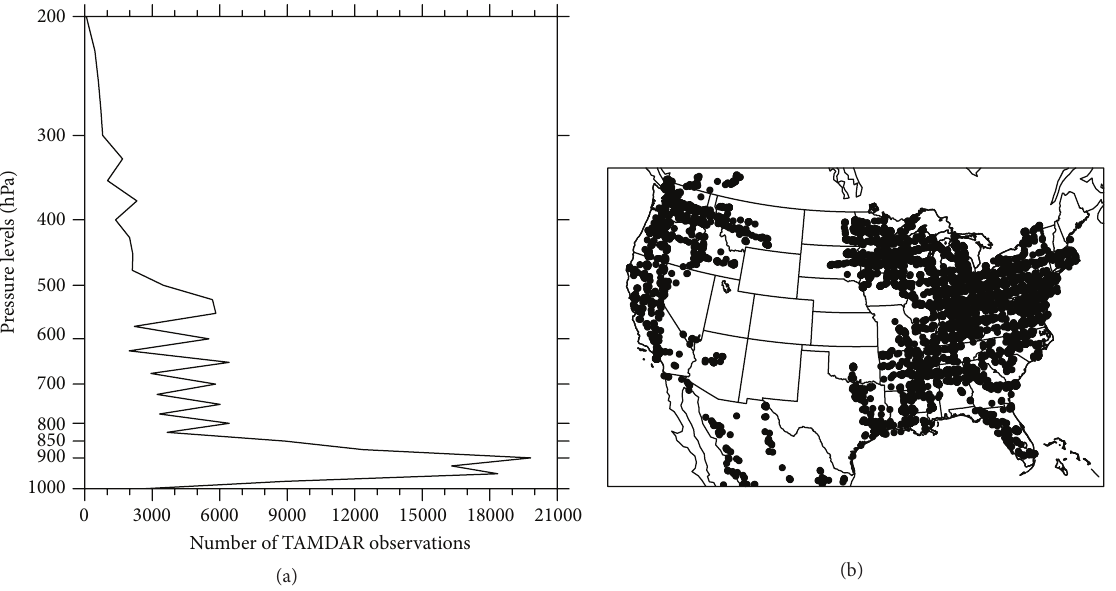
Figure 2: Vertical distributions of the number of the TAMDAR observations (a) and horizontal coverage of the TAMDAR observations (b) during August 1 through 6, 2009 (plotted every 12th